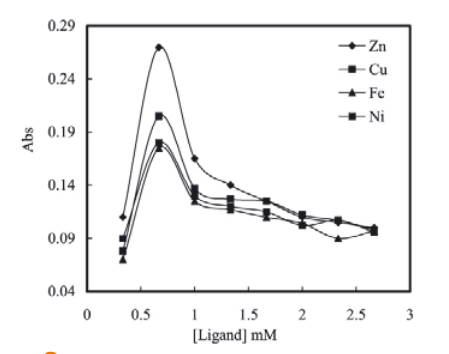
Figure 2. Effect of ligand concentration on CPE of analyte